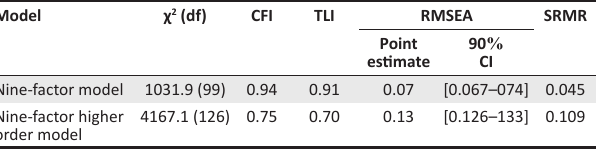
TABLE 3: Goodness-of-fit statistics for the nine-factor and nine-factor higher order models.